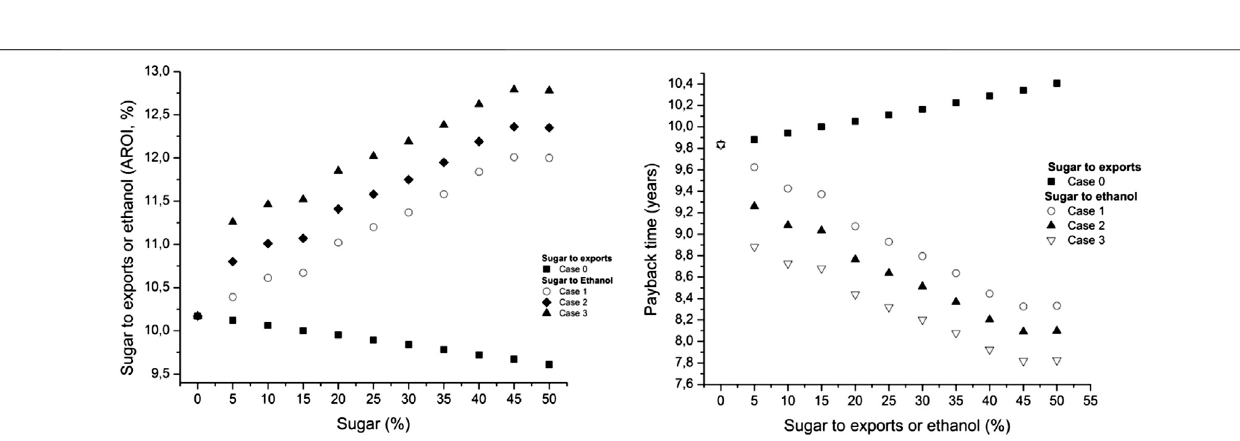
Frontiers in Energy Research |